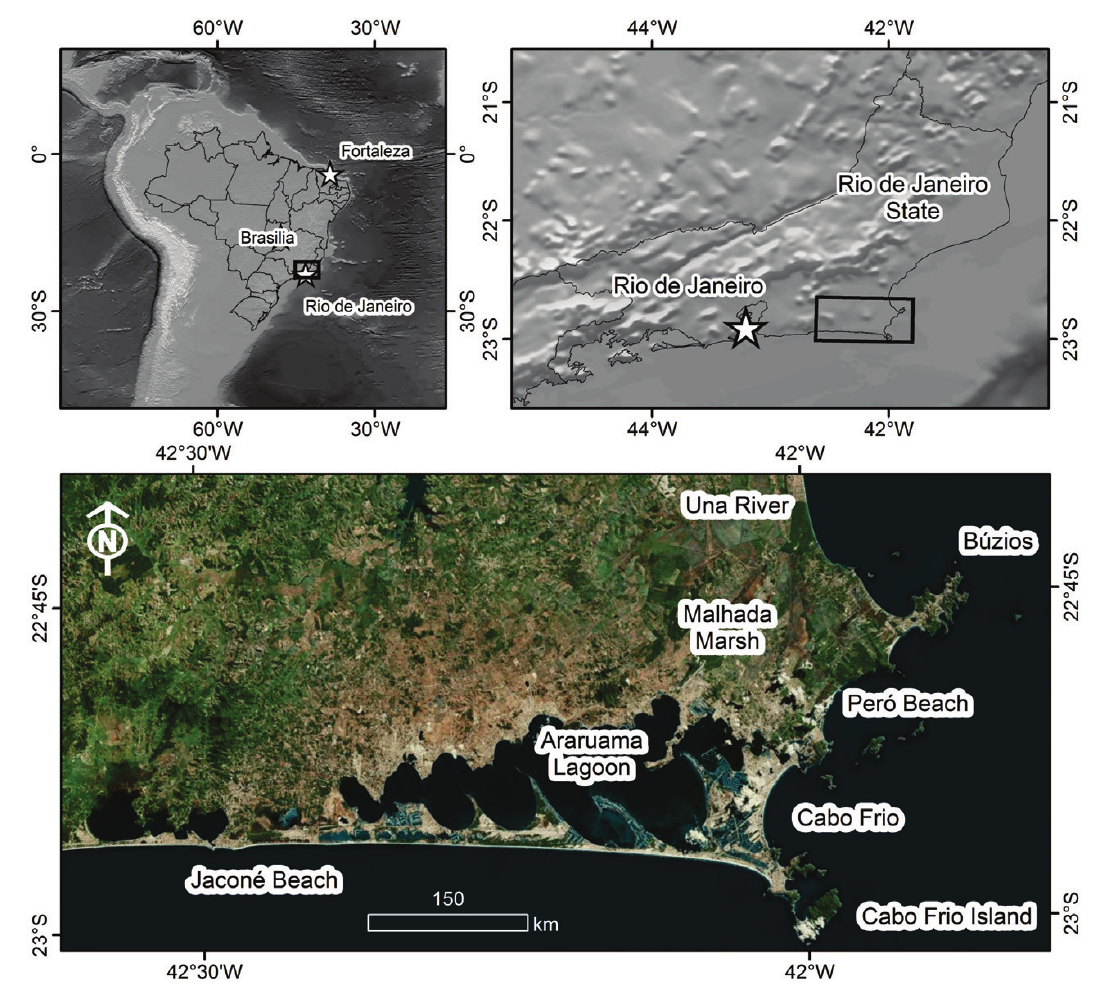
Figure 1 - Location of the study area in the state of Rio de Janeiro, southeastern